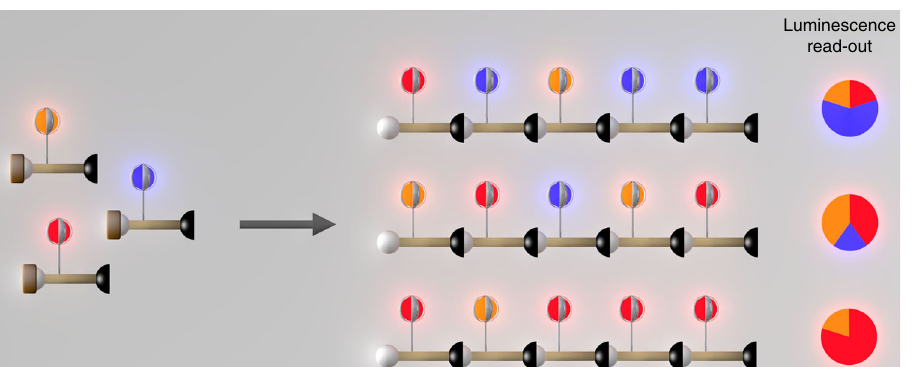
Fig. 1 Previous work. State-of-the-art in oligonuclear lanthanoid complexes.